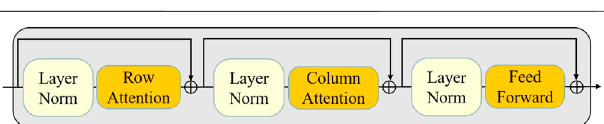
FIGURE 2 | Architecture of the MSA Transformer block. Here, the residualconnectionisusedbetweentheadjacentsub-modules.The fi rstsub- module is used to achieve a single attention map of all rows by using an axial attention layer. The second sub-module is used toextract the feature for columns of input feature maps by using a multihead self-attention layer. The last sub-module is implemented by using a multilayer perceptron layer.